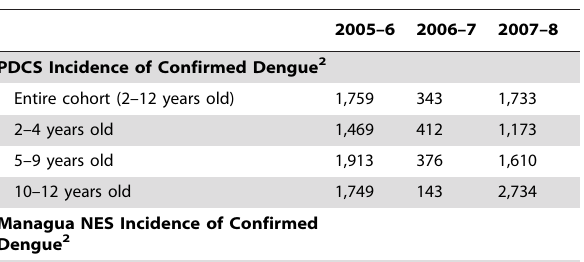
Table 2. Age-stratified incidence and expansion factors 1